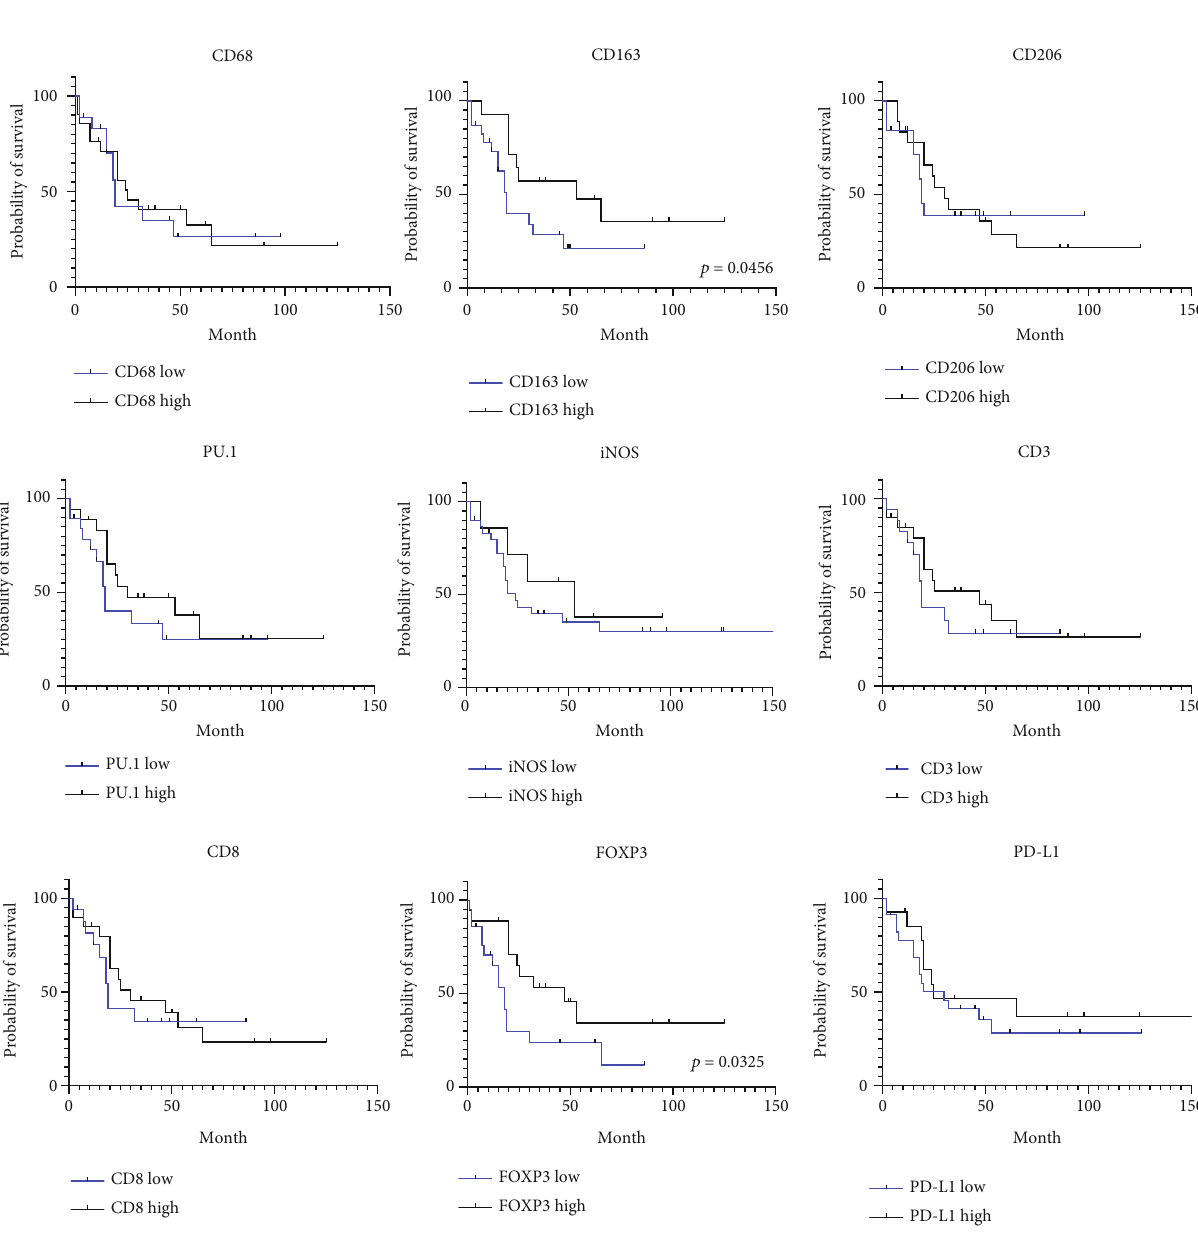
Figure 1: Kaplan – Meier curves of overall survival (OS) in esophageal squamous cell carcinoma (ESCC) based on TILs and